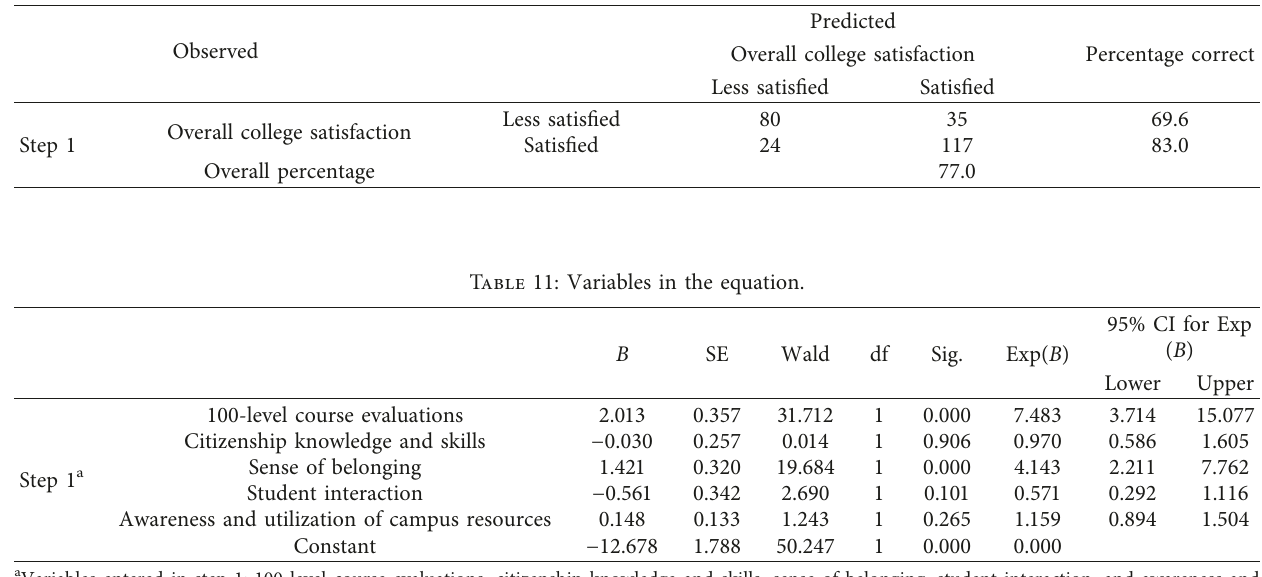
Table 10: Classification table.